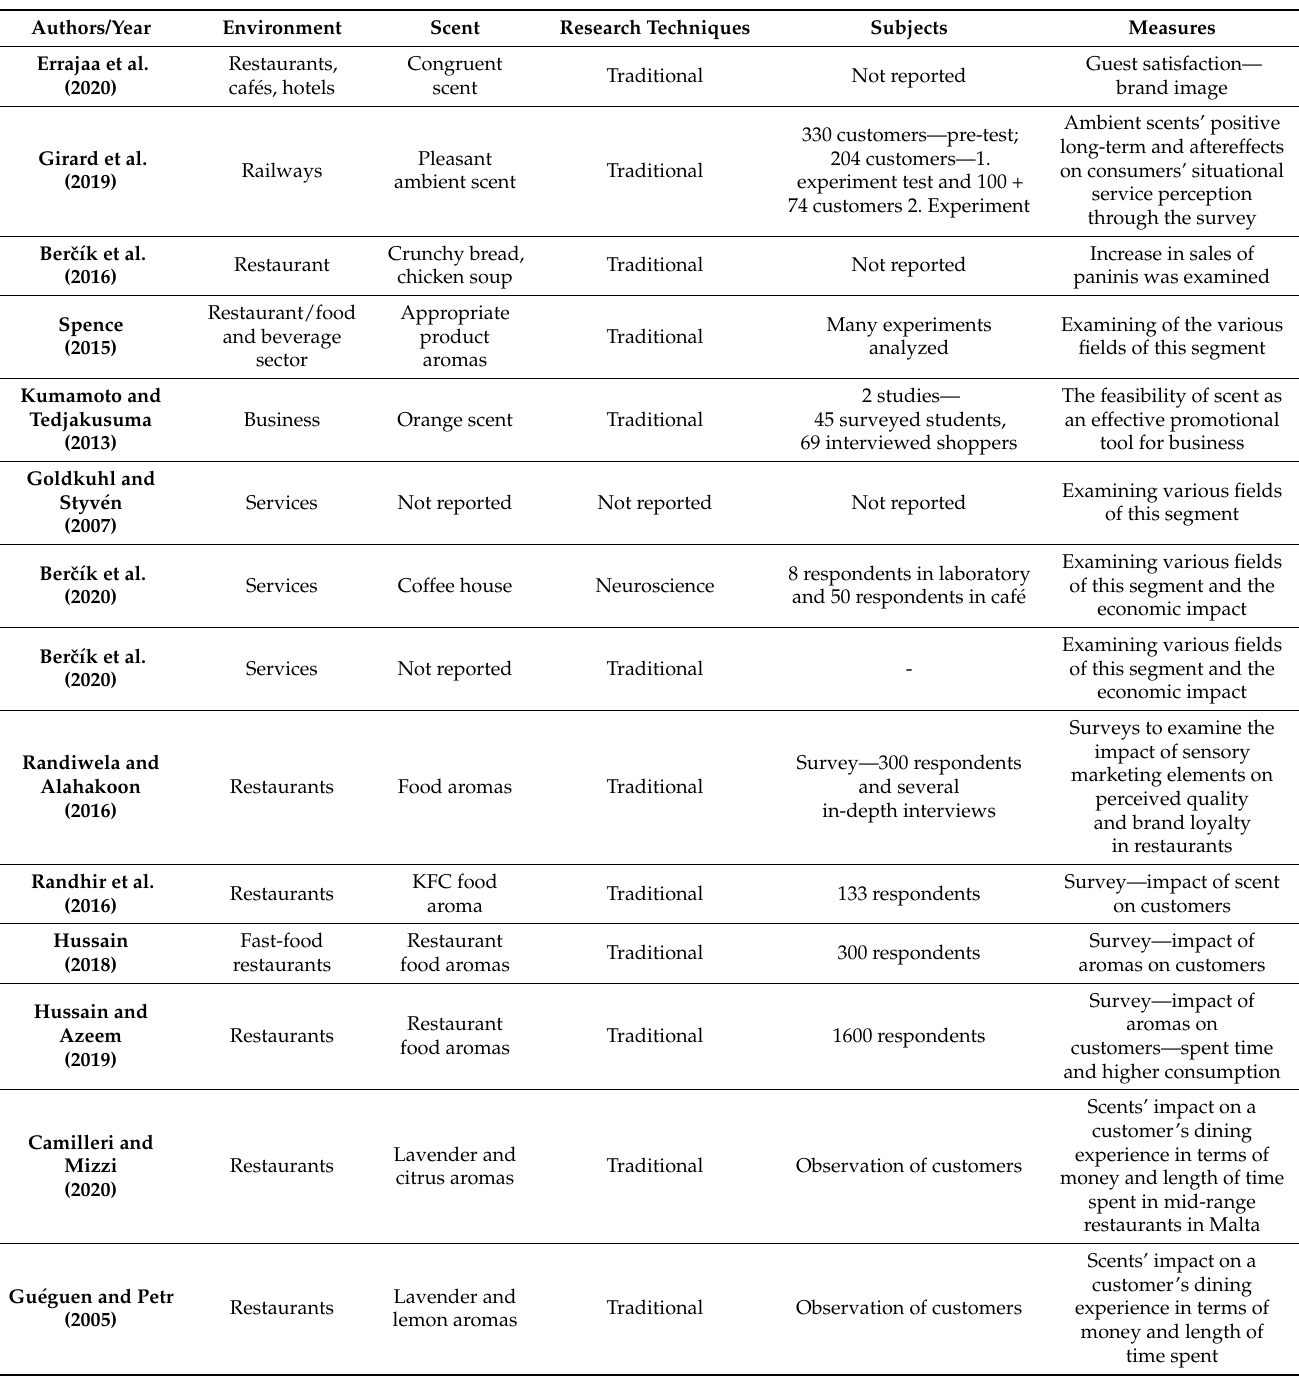
Table 2. Studies related to aroma marketing in various segments of